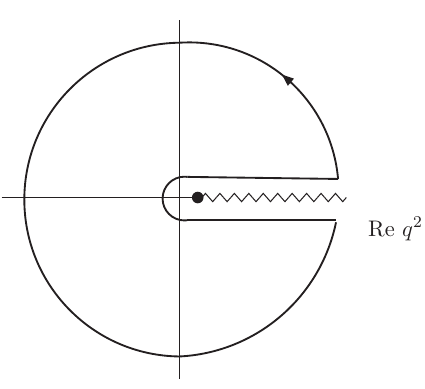
Figure 2: Analytic structure of Π ( q 2 ) in the complex z = q 2 plane. There is a cut on the positive real axis starting at s = q 2 = m 2 contour used in Eq.